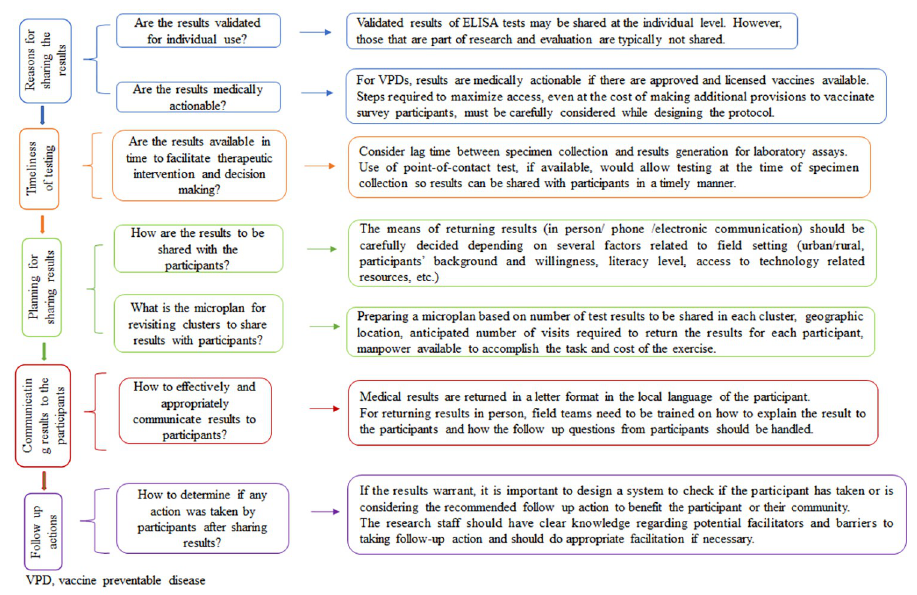
Fig 2. Decision flowchart to be used while returning results to participate of large scale serosurveys.